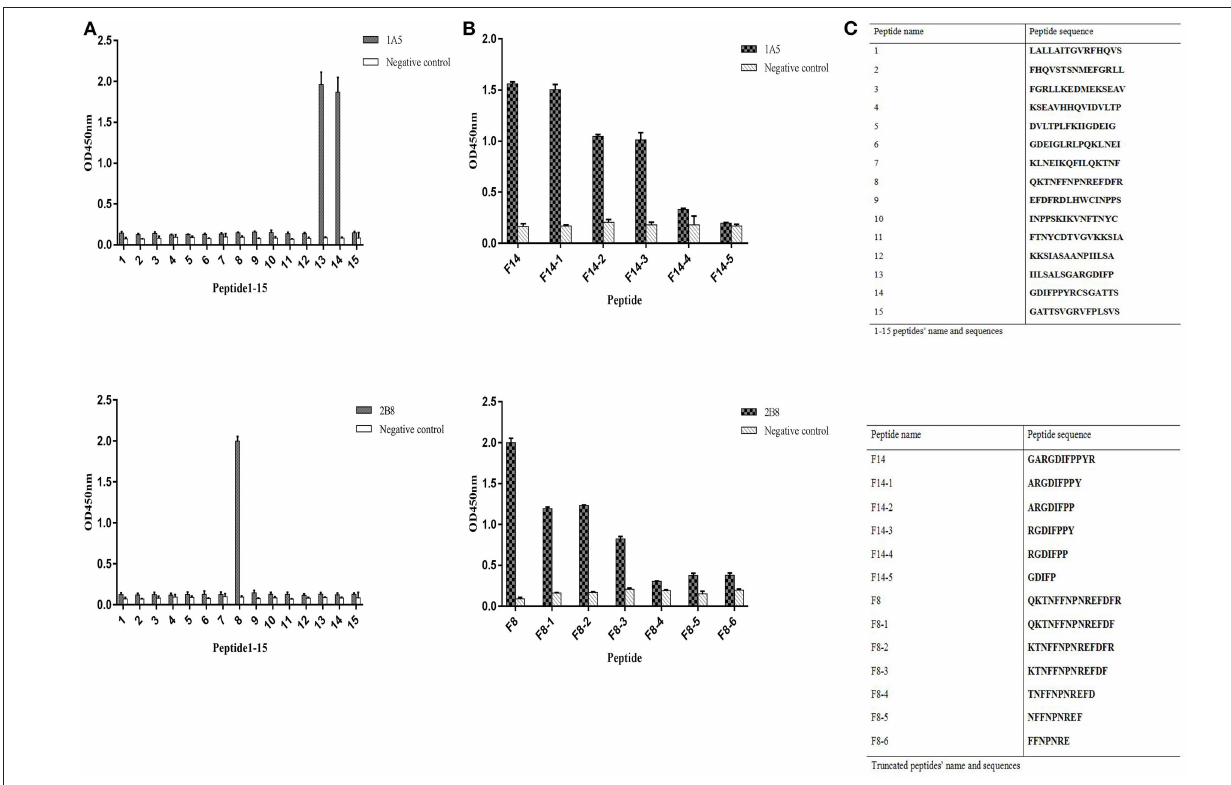
FIGURE 2 | Identification of the epitope recognized by hemagglutinin (H)-reactive mAbs. (A) H protein–reactive mAbs were screened by indirect ELISA against a panel of 15 overlapping peptides derived from the CDV H protein (aa 50–204). The mAbs are listed in the upper right-hand corner of each bar graph. The Pc11 mAb was used as a negative control. The error bars display the standard deviation of three experimental repeats ( n = 3). (B) The mAbs were screened against a series of progressively truncated peptides based on the results of the initial screen shown in the panel. The mAbs are labeled on the top right corner of each bar graph.